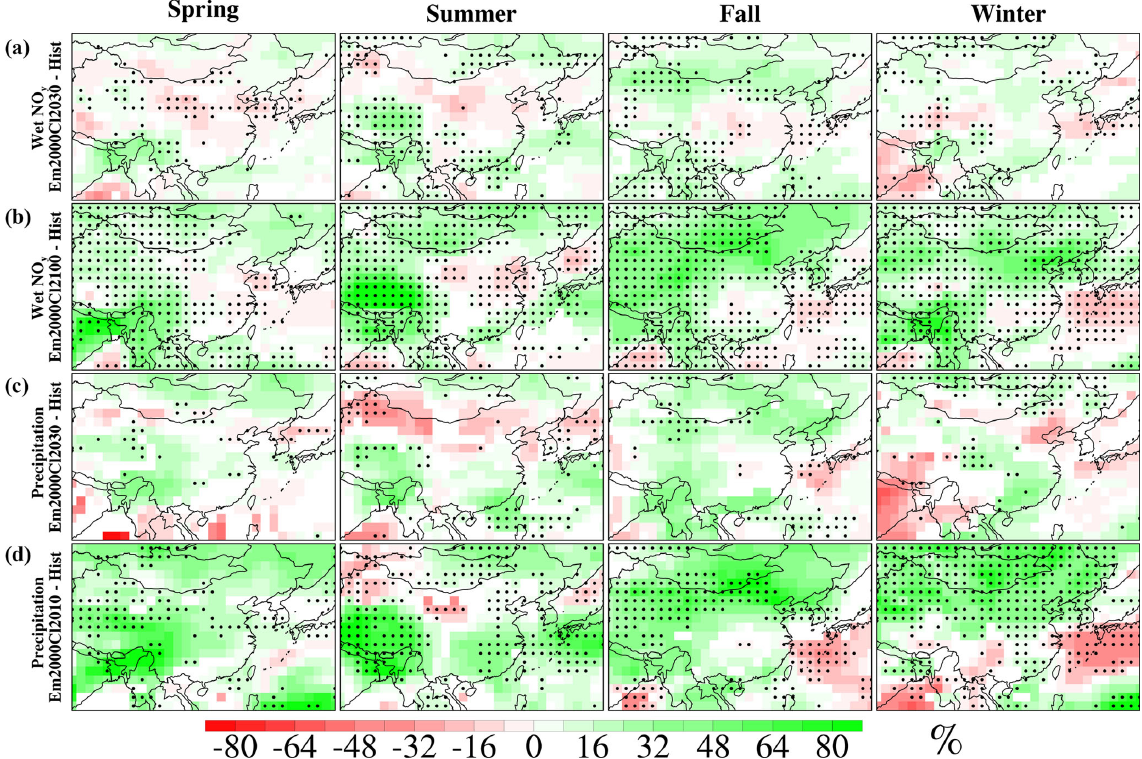
Figure 6. Spatial distribution of mean seasonal wet NO y deposition change and precipitation change under EM2000Cl2030 and Em2000Cl2100 relative to the historical period (2001–2010). The panels are drawn and arranged in the same manner as Fig. 2.